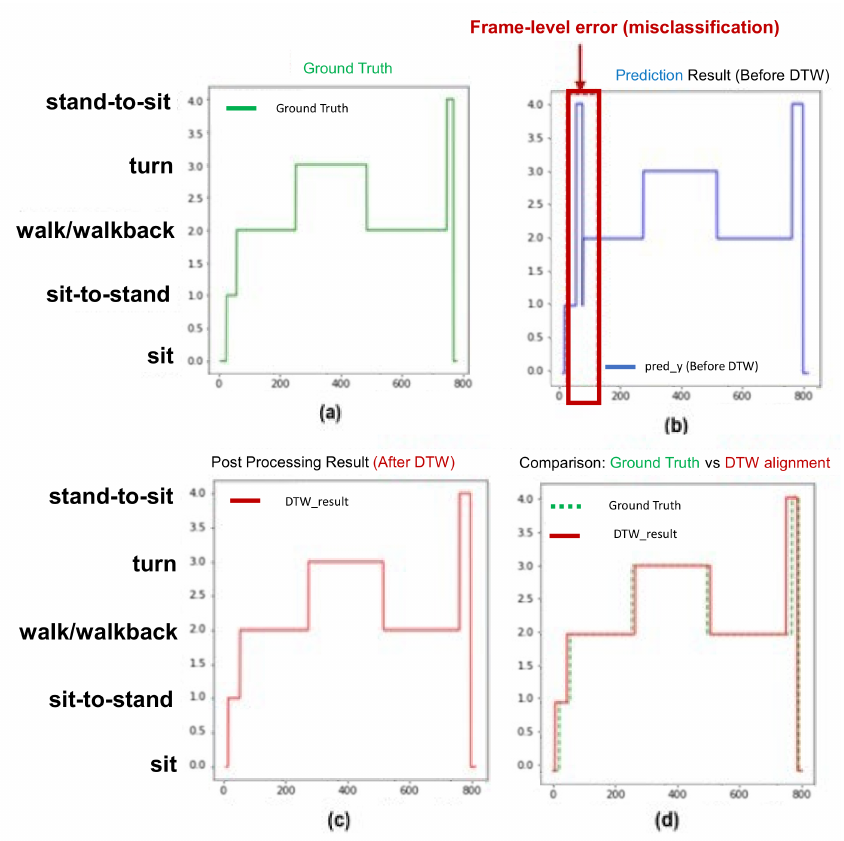
Figure 5. Sample postprocessing for correcting frame-level